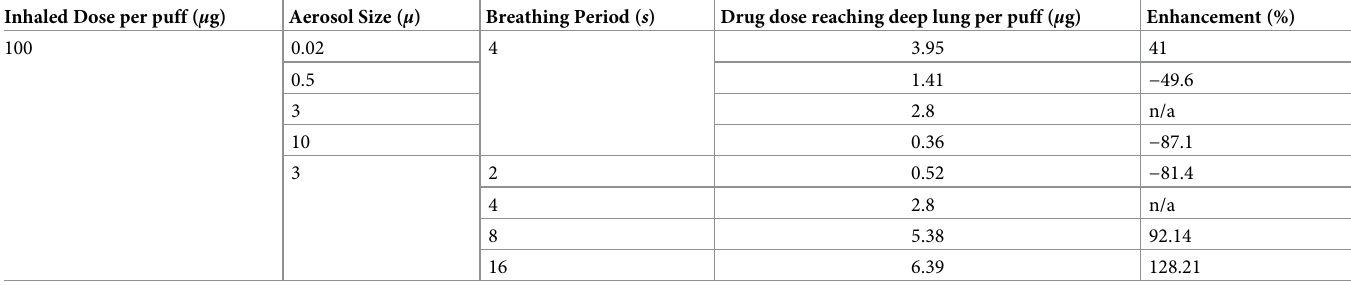
Table 1. Comparison of drug dose delivered to the deep lung for various aerosol sizes and breathing periods. The aerosols carry the drugs and are generated from inhalers. It is assumed that 10% of the aerosols inhaled reach the trachea for further inhalation into the deep lung [26]. Enhancement is calculated with respect to 3 μ m aerosols for 4s breathing